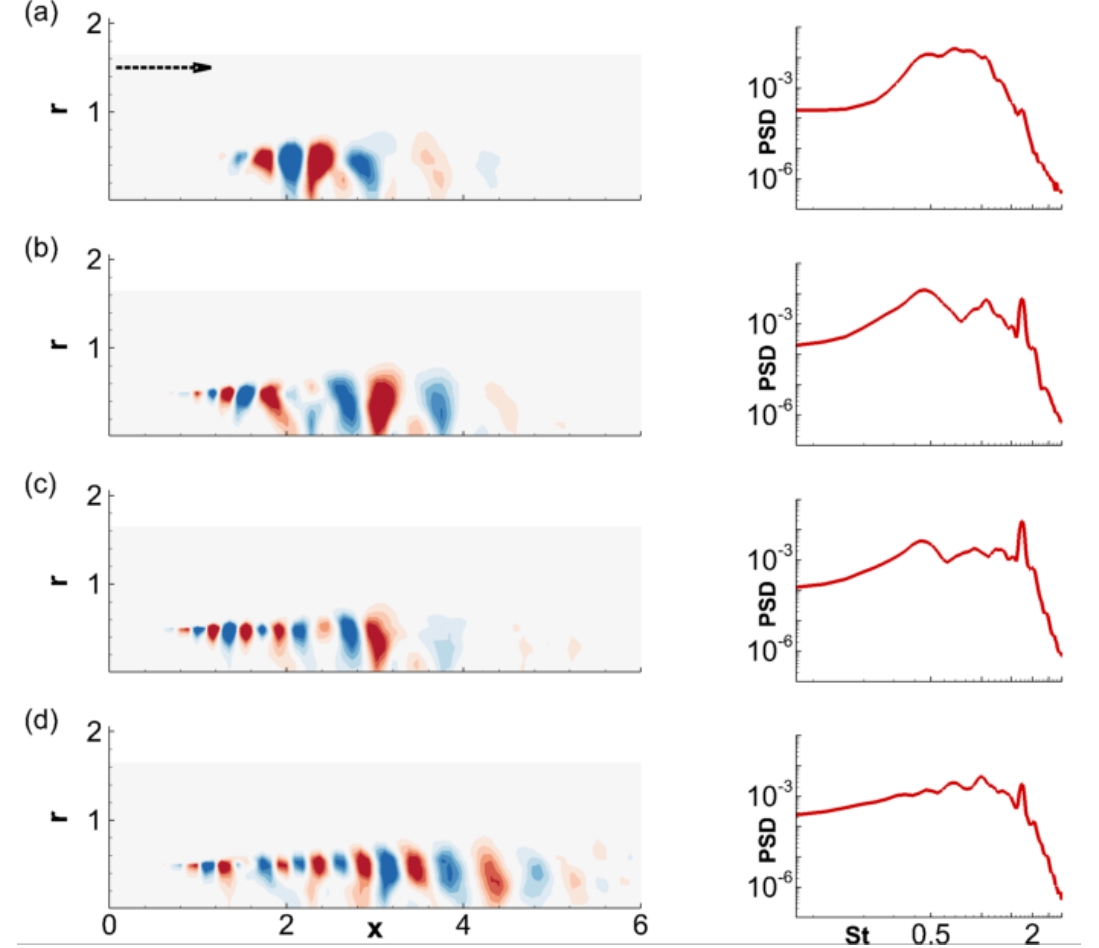
Figure 9. POD modes of the field u · ∇ p , along with the PSD of the corresponding modal time-coefficient. The modes shown are: ( a ) mode 1; ( b ) mode 3; ( c ) mode 5 and ( d ) mode 7. The horizontal dotted arrow in ( a ) marks the jet-flow direction. Frames a - d share the same abscissa and